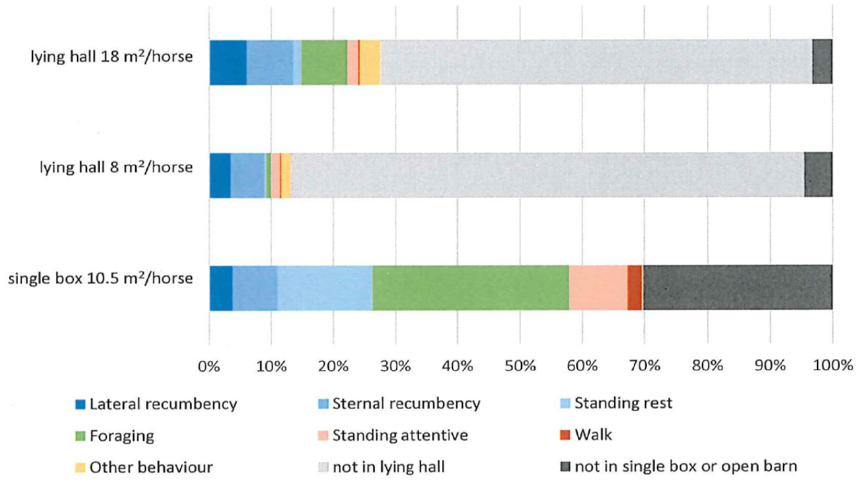
Figure 6. The chart shows the time budgets for single boxes and active open barn with lying areas of 8 m 2 and 18 m 2 in Study 2 in Strömsholm based on 10 horses.